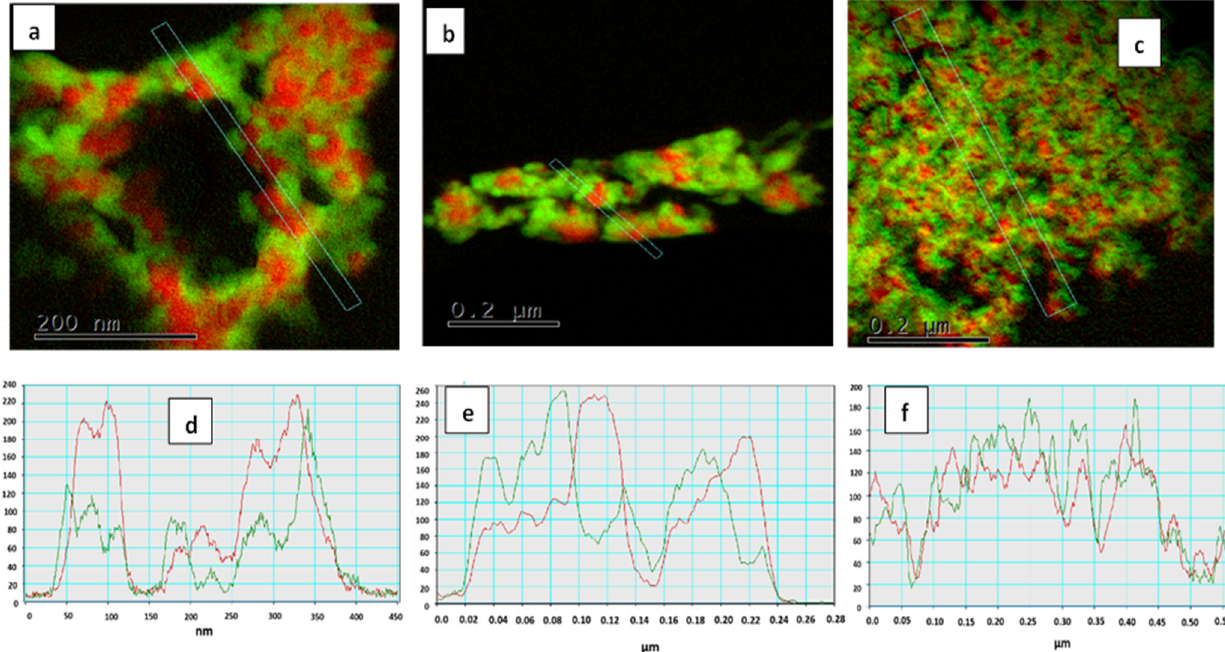
Figure 6. FIB-HRTEM-EELS images and La-, Fe-concentration profiles of slices from the particles of Fe 2 O 3 @LSF core-shell materials CS-4 ( a , d ), CS-3 ( b , e ) and CS-5 ( c , f ). La- green; Fe- red.